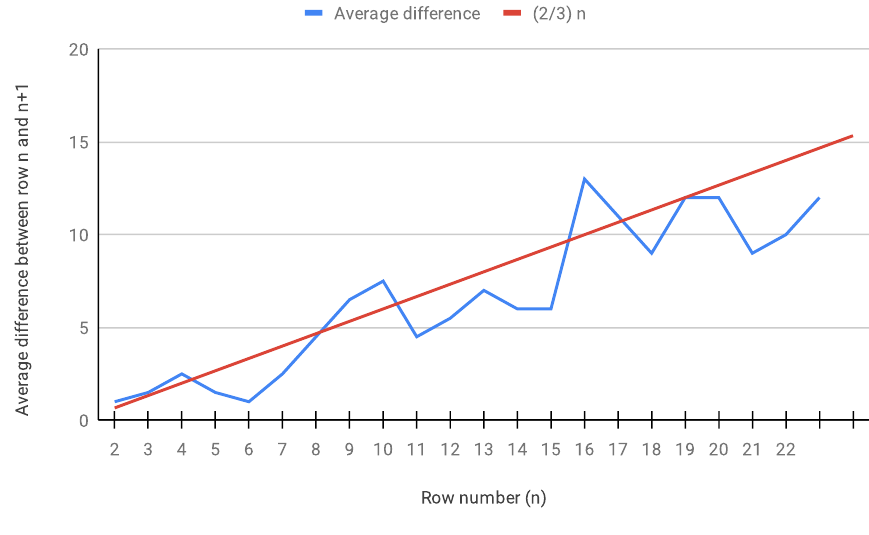
Figure 16. Average difference between row n and n + 1 in absolute values (not proportion) and not logarithmic